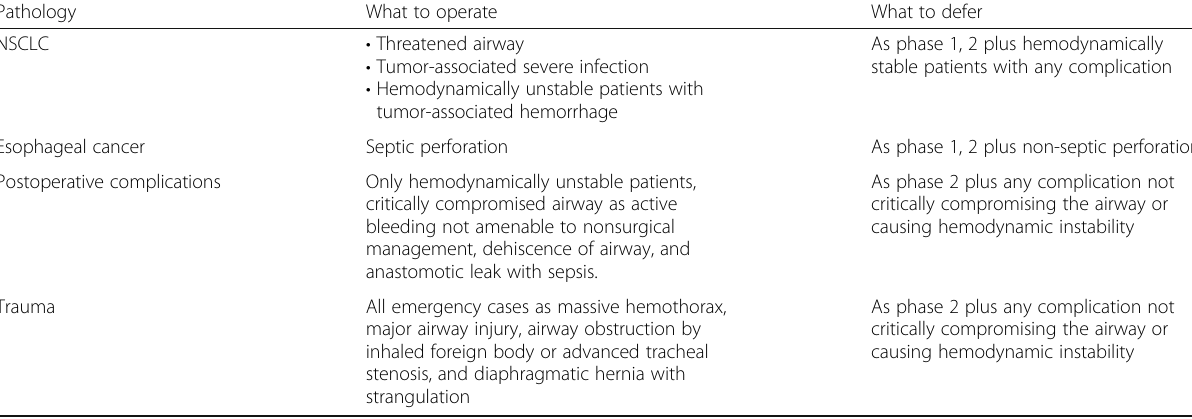
Table 3 Summary for decision-making in different pathologies during phase 3 Pathology